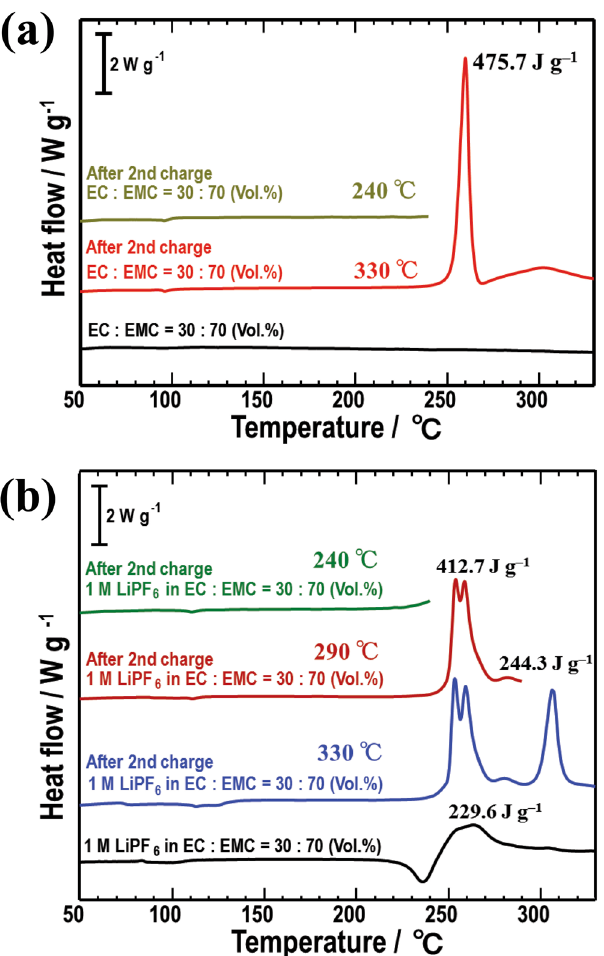
Figure 3. The DSC curves of the NMC composites after the 2nd charge cycles in the presence of ( a ) only the EC/EMC solution and ( b ) the 1 M LiPF 6 -EC/EMC solution. For reference, the DSC curves of only EC/EMC solvent and only LiPF 6 and EC/EMC solvent are shown at the bottom in ( a , b ),